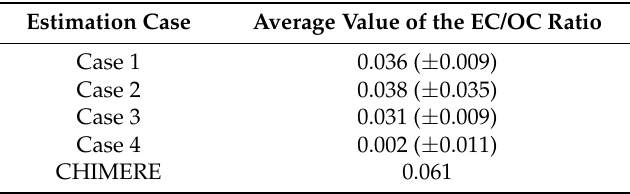
Table 4. Average values of the EC/OC ratio estimates derived from the AERONET observations according to different estimation cases along with the corresponding value predicted by simulations with the CHIMERE model. The numbers in parentheses indicate the 90% confidence intervals for the average estimates based on observations. The uncertainty of the model predictions has not been evaluated in this